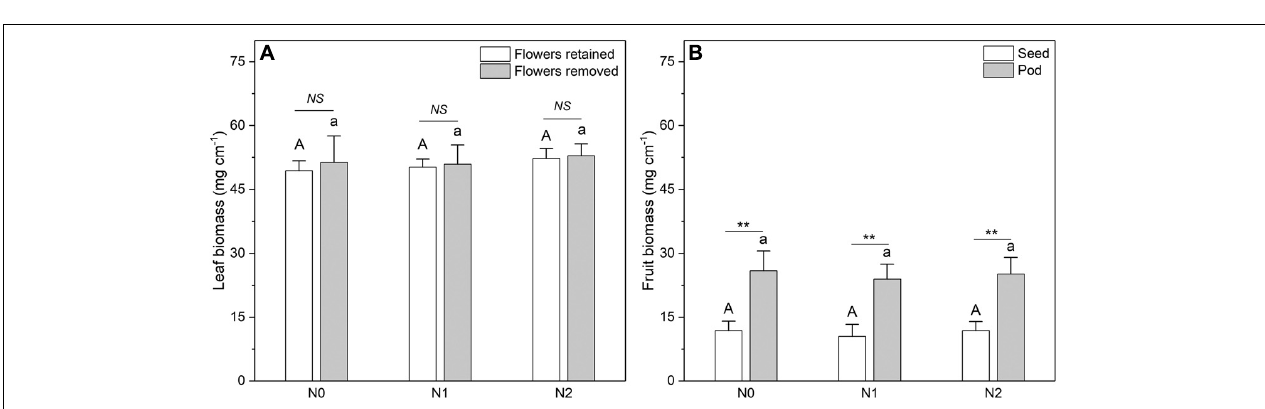
FIGURE 6 | Biomass of (A) leaves and (B) fruits at different N addition levels. N addition [ n = 6 for plants with sink decrease (Flowers removed); n = 11 for plants without sink decrease (Flowers retained)]: N0 (control), with no N addition; N1, 56 g N per individual; N2, 112 g N per individual. Values are means ± SE. Bars labeled with different letters differ significantly between N addition levels for (A) plants without flower removal (upper-case letters, i.e., A, B) and with flower removal (lower-case letters i.e., a, b) for leaf biomass and (B) between seed biomass (upper-case letters, i.e., A, B) and fruit biomass (lower-case letters i.e., a, b). In (A) , differences between sink decrease treatments were not significant; in (B) seeds and pods differed significantly (**one-way ANOVA, P < 0.01). For differences at a given N addition level, NS represents non-significance; **represents a significant difference ( t -test, P < 0.01).